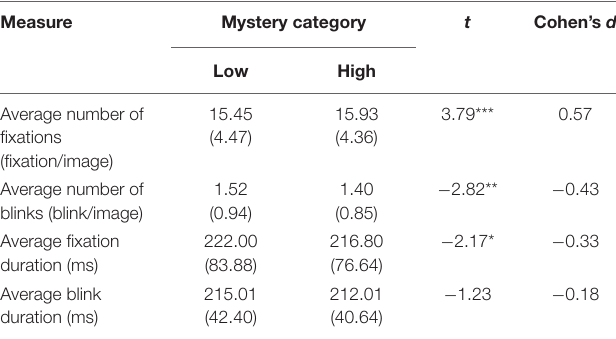
TABLE 1 | Mean, standard deviation (in parentheses) and results of the paired-sample t -tests for the four measures of blink and fixation calculated for each type of mystery